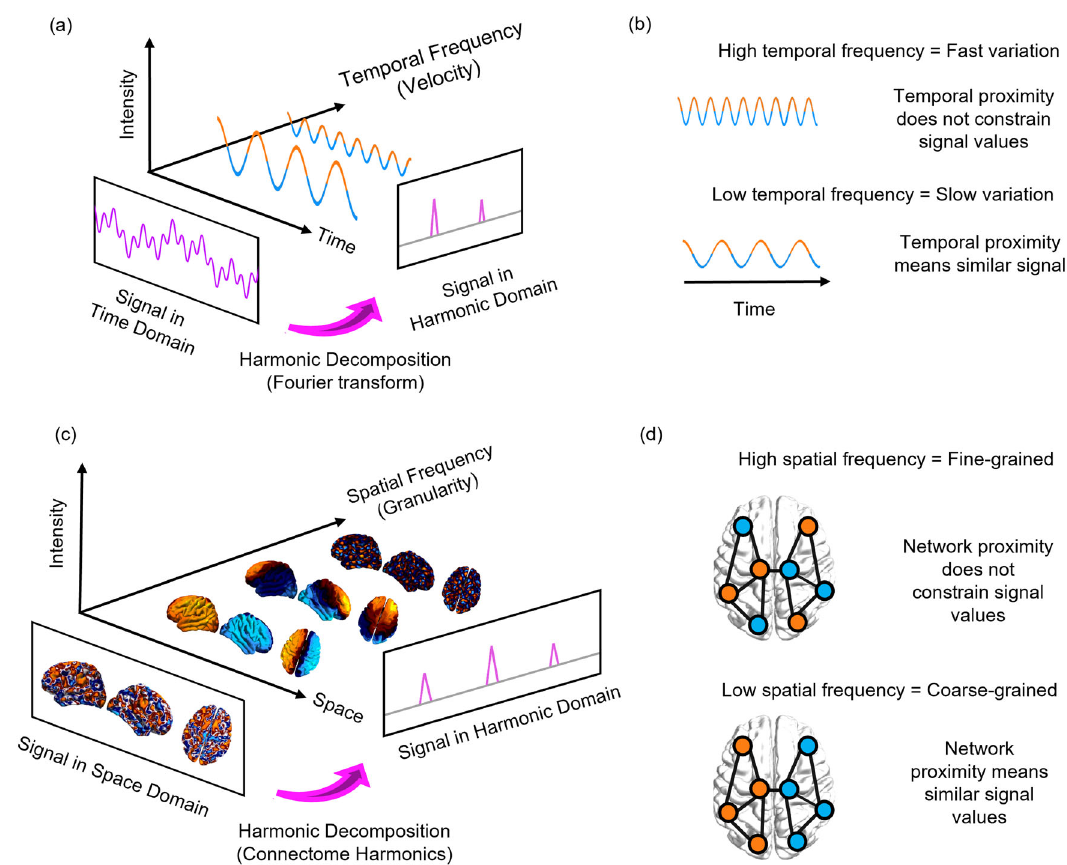
Fig. 1 Connectome harmonic decomposition generalises the Fourier transform to the network structure of the human brain. a In traditional Fourier analysis, a signal in the time domain (represented in terms of sequential time-points) is decomposed into temporal harmonics of different frequency, thereby re-representing it in terms of a new set of basis functions. b High-frequency temporal harmonics correspond to fast-changing signals, such that data-points may have very different values even if they are close in time; in contrast, low-frequency temporal harmonics correspond to signals that vary slowly over time, such that temporally contiguous data-points have similar values, re fl ecting greater time-dependence of the signal. c In connectome harmonic decomposition, a signal in the space domain (represented in terms of BOLD activation at discrete spatial locations over the cortex) is decomposed into harmonic modes of the human structural connectome, providing a new set of basis functions in terms of whole-brain distributed patterns of activity propagation at different scales, from global patterns of smooth variation along geometrical axes (left – right and anterior – posterior being the most prominent) to increasingly complex and fi ne-grained patterns. Note that here, frequency is not about time, but about spatial scale (granularity). d Low- frequency (coarse-grained) connectome harmonics indicate that the spatial organisation of the functional signal is closely aligned with the underlying organisation of the structural connectome: nodes that are highly interconnected to one another exhibit similar functional signals to one another (indicated by colour). High-frequency ( fi ne-grained) patterns indicate a divergence between the spatial organisation of the functional signal and the underlying network structure, whereby nodes may exhibit different functional signals even if they are closely connected in the